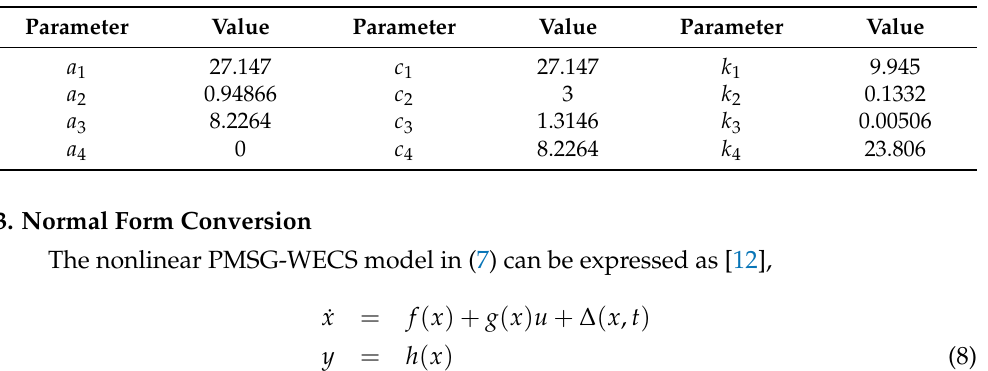
Table 2. Parameters